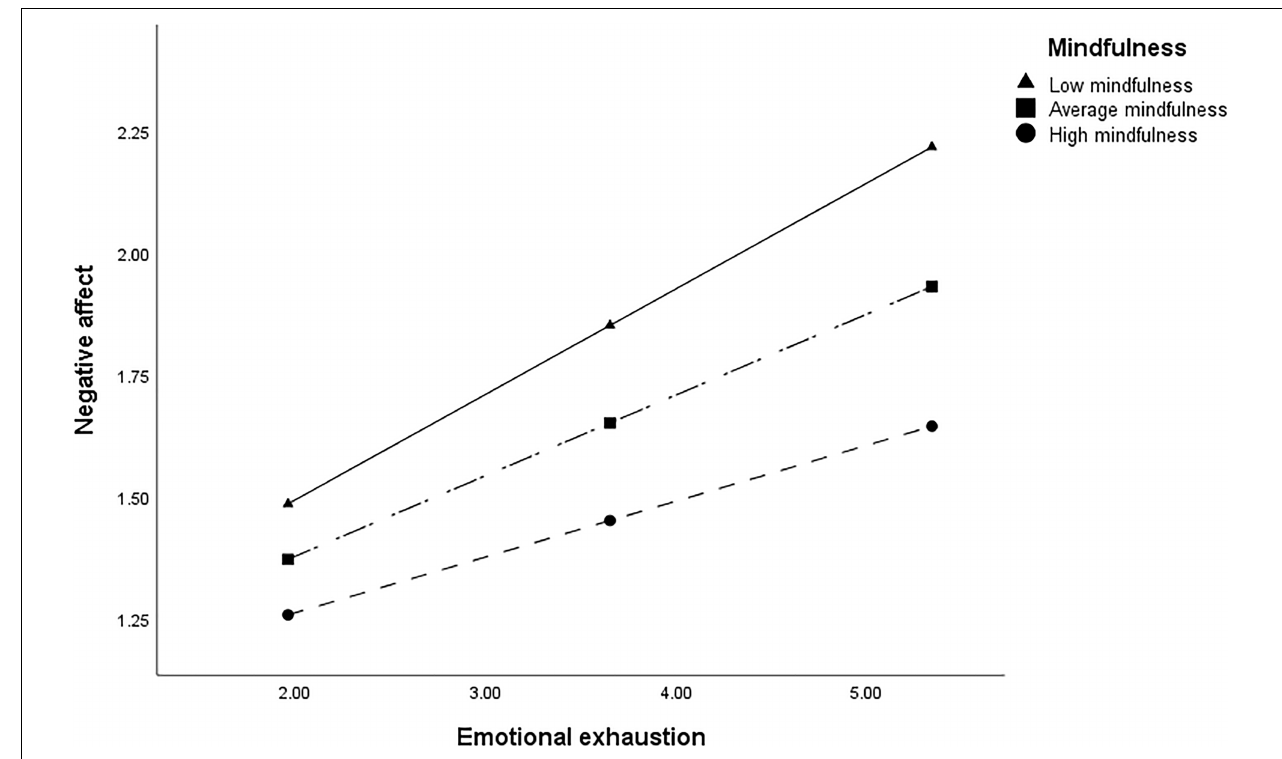
FIGURE 2 | Moderating effect of mindfulness on the relationship between leader emotional exhaustion and negative